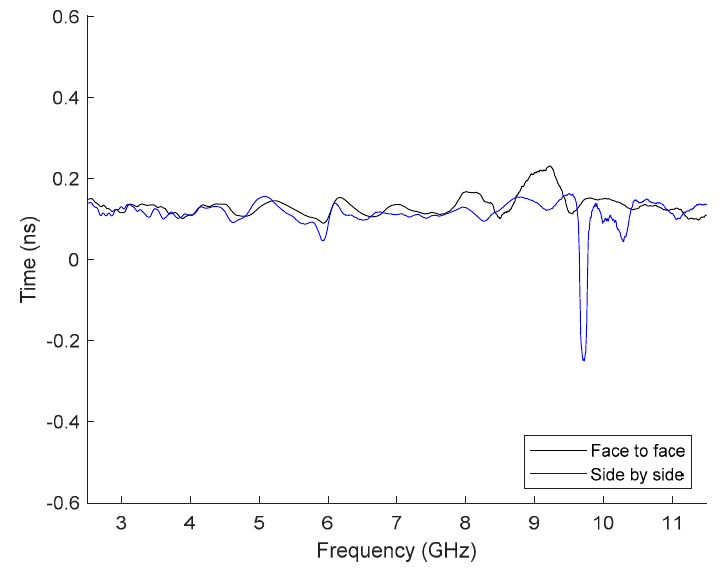
Figure 14. Group delay for the face-to-face and side-by-side setup configuration. To check the characteristics of the antenna with broadband signals, such as those used in UWB communications or in medical imaging systems, the transmission of a broadband pulse was analysed in the two configurations previously studied, face-to-face and side-by-side. The pulse used is based on a Gaussian pulse. The Gaussian pulse is defined in (4), where σ is the pulse width at half power [38].